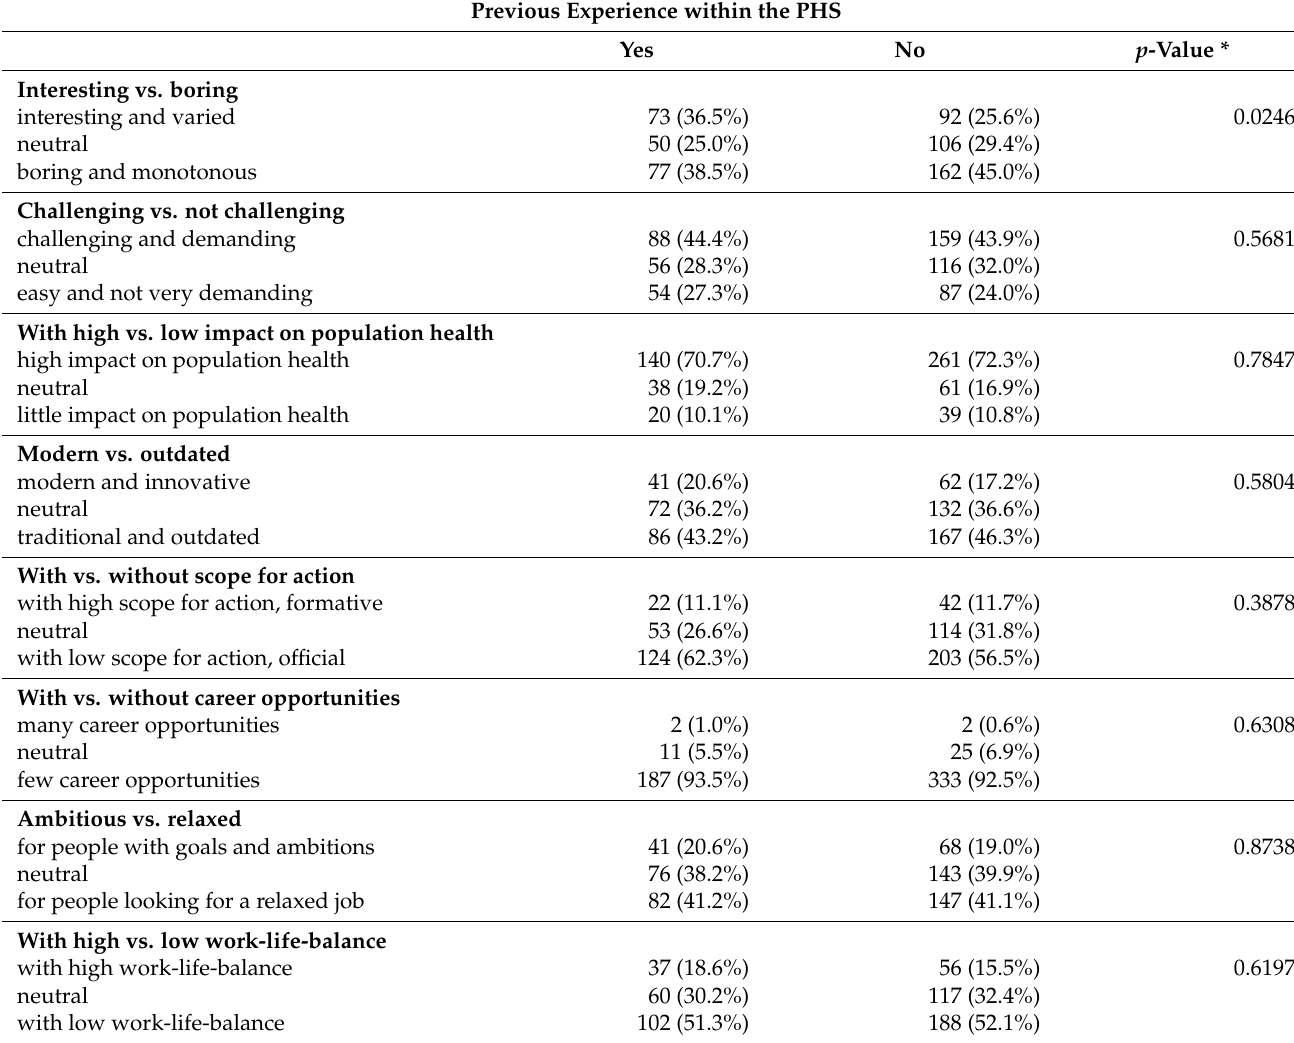
Table A6. Polarity profile: Characteristics associated with an activity in the Public Health Services (PHS) by previous experience within the PHS: Absolute and relative proportion of grouped responses by field of study and PHS interest in wave 2, OeGD-Studisurvey.